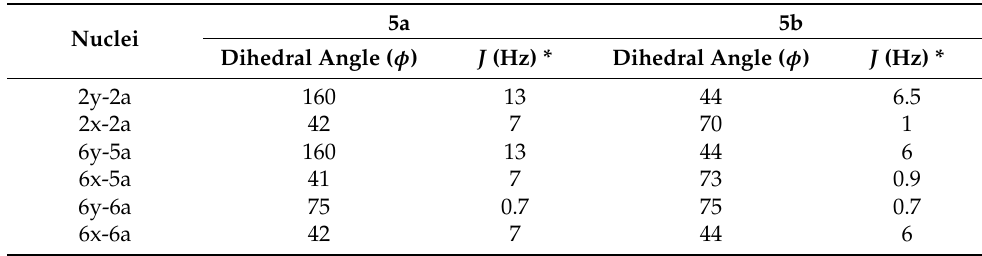
Table 2. Dihedral angles for compounds 5a and 5b and corresponding coupling constants according to Karplus equation [17].